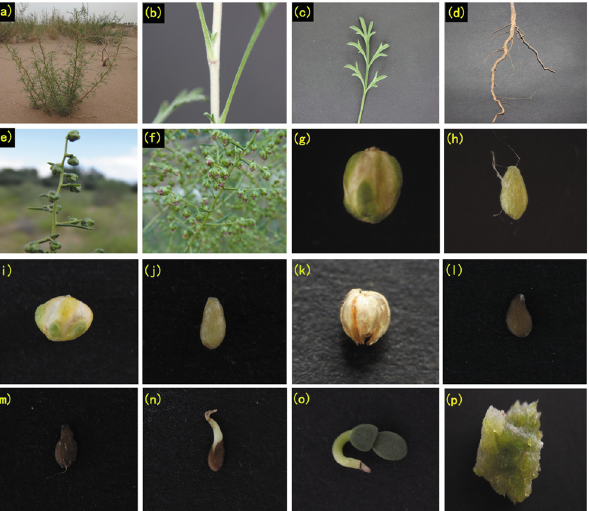
Fig 1. The morphologies of various Artemisia sphaerocephala tissues. Note: (a) Whole plant, (b) stem, (c) leaf, (d) root, (e) flower bud, (f) flower, (g) early developing seed husk, (h) early developing seed, (i) mid- developing seed husk, (j) mid-developing seed, (k) mature seed husk, (l) mature seed, (m) germinating seed at 3 days, (n) germinating seed at 7 days, (o) seedling, and (p) callus cell.